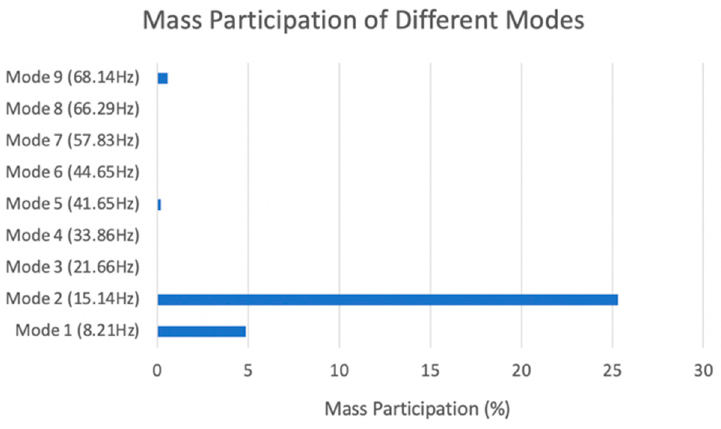
Figure 12. Mass participation of different modes.